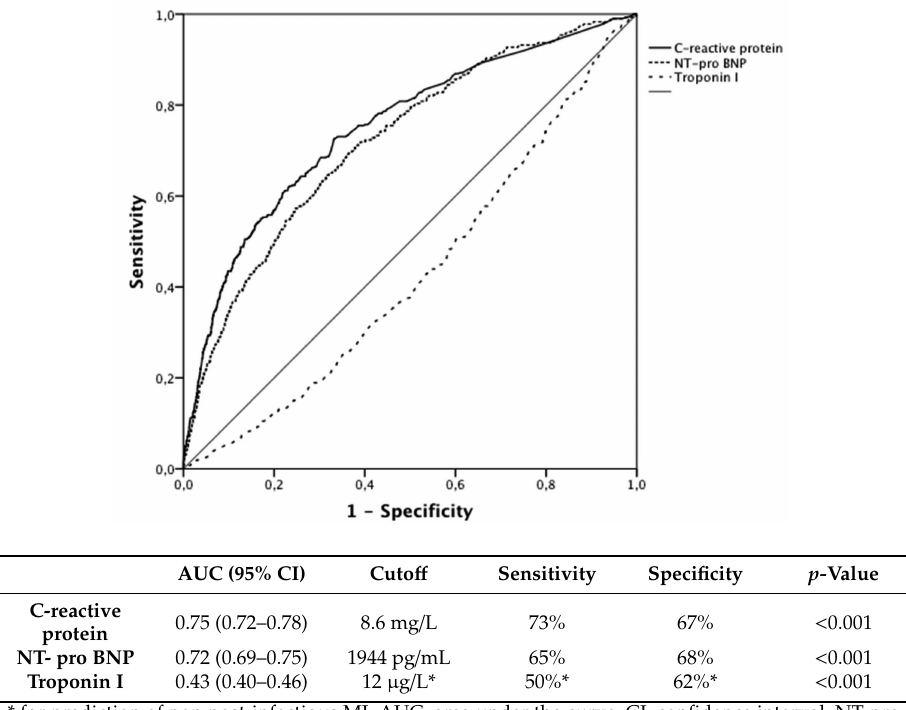
Figure 3. Receiver operating curves of predictive biomarkers for post-infectious myocardial infarction.